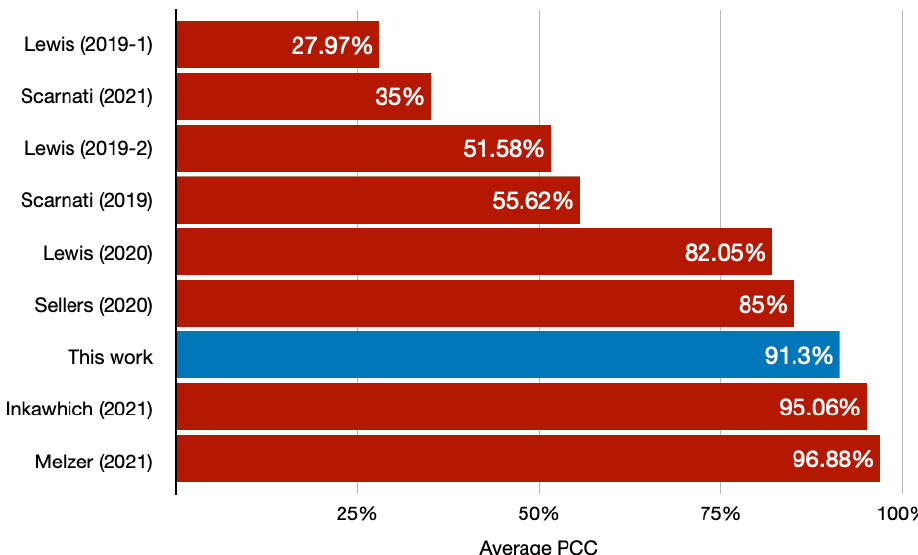
Figure 21. Classification results (PCC) of all works, the training of which was performed using purely synthetic